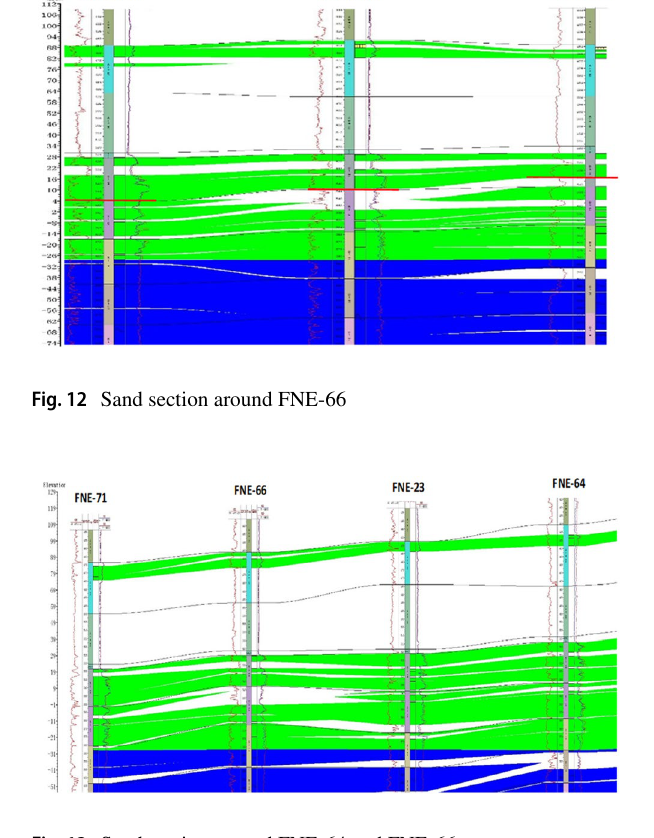
Fig. 13 Sand section around FNE-64 and FNE-66